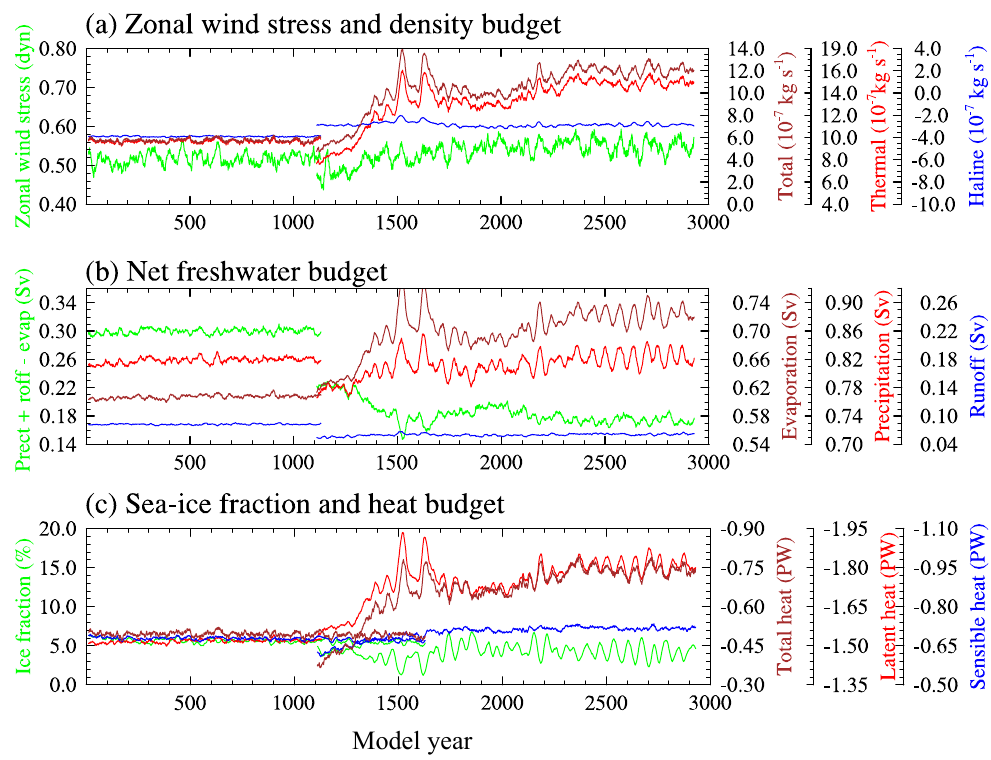
Figure 6. As in Fig. 3, but for the North Pacific basin at 30–70 ◦ N.